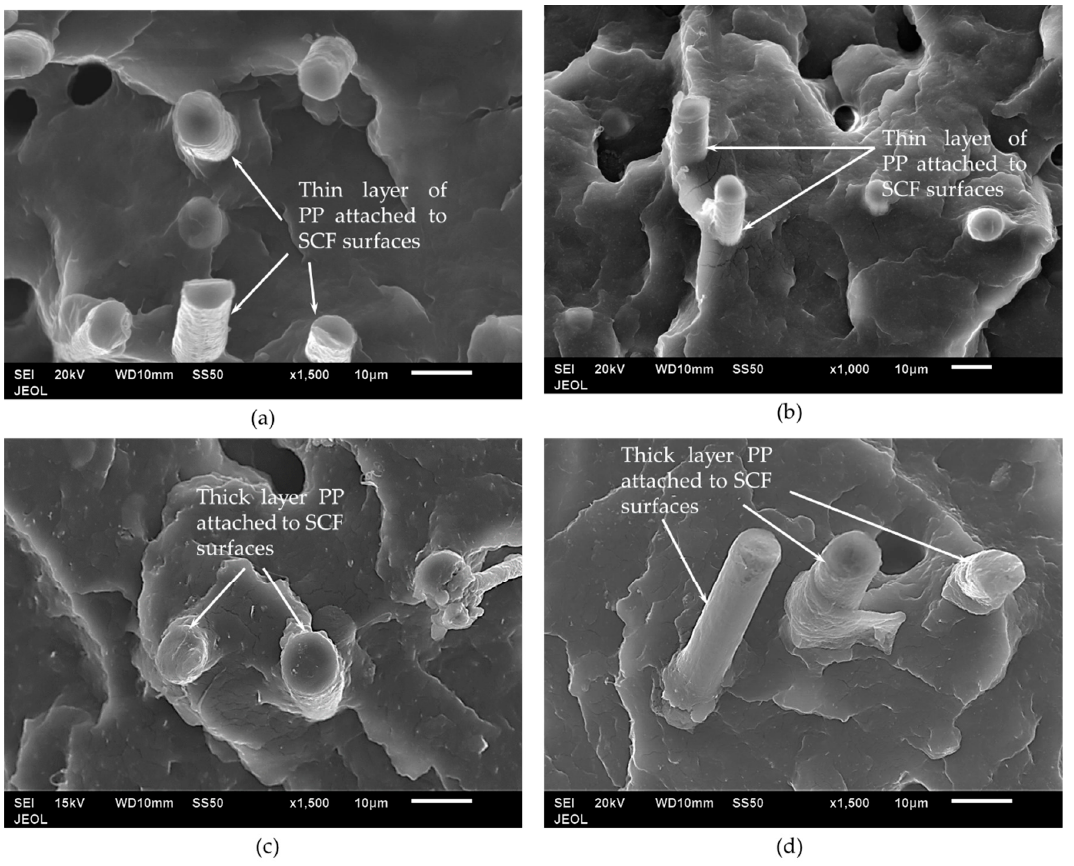
Figure 7. SEM images microstructures of ( a ) PP / 15SCF, ( b ) PP / 10SCF / 5nTiO 2 , ( c ) PP / 10SCF / 5GNP, and ( d ) PP / 10SCF / 2.5GNP / 2.5nTiO 2 composites.